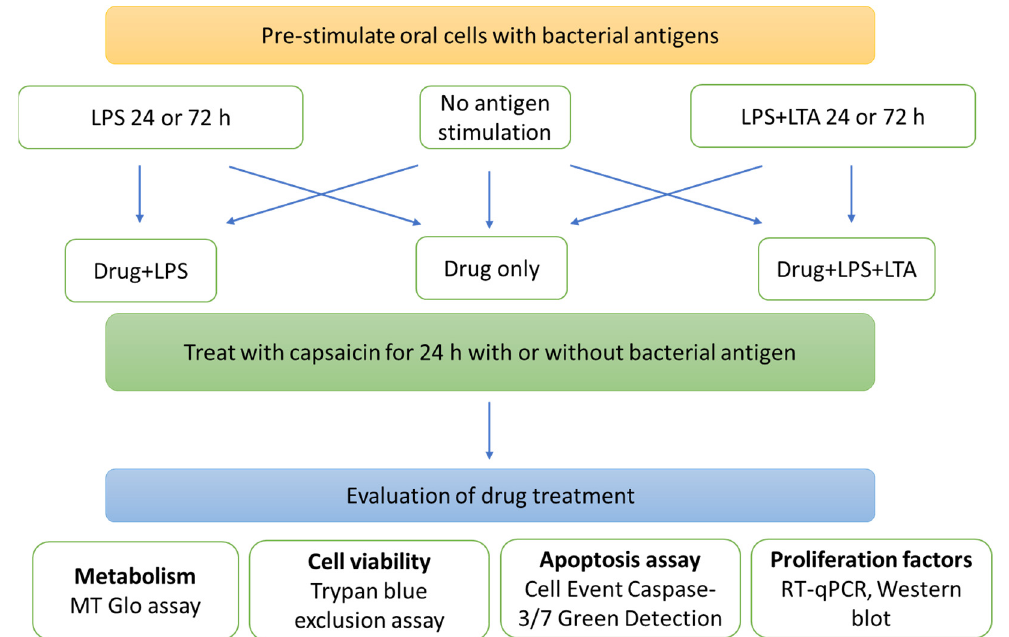
Figure 8. Experiment overview. Cal 27 and OKF6 cells were pre-stimulated with no bacterial anti- gen, LPS 5 µg/mL or combined LPS 5 µg/mL + LTA 5 µg/mL for 24 or 72 h. The media was